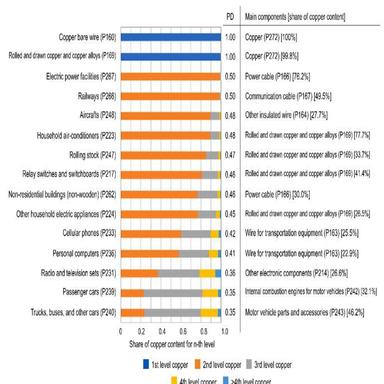
In-product density (PD) and share of copper content at each level in selected final products in Japan in 2011.